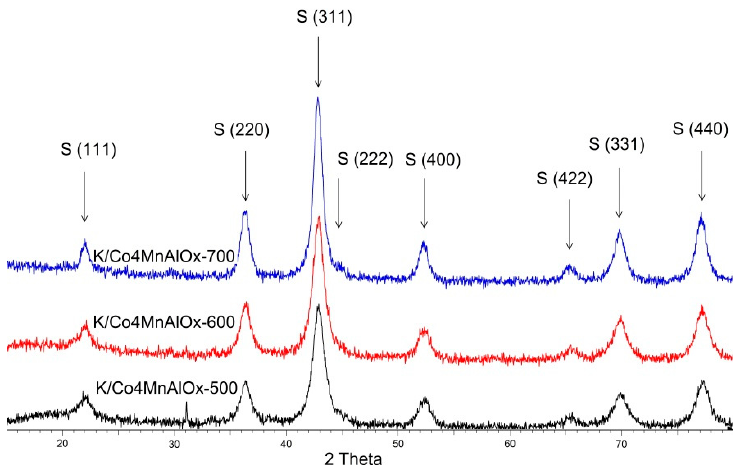
Figure 1. Powder XRD patterns of the K/Co 4 MnAlO x mixed oxide calcined at different temperatures. S—spinel.